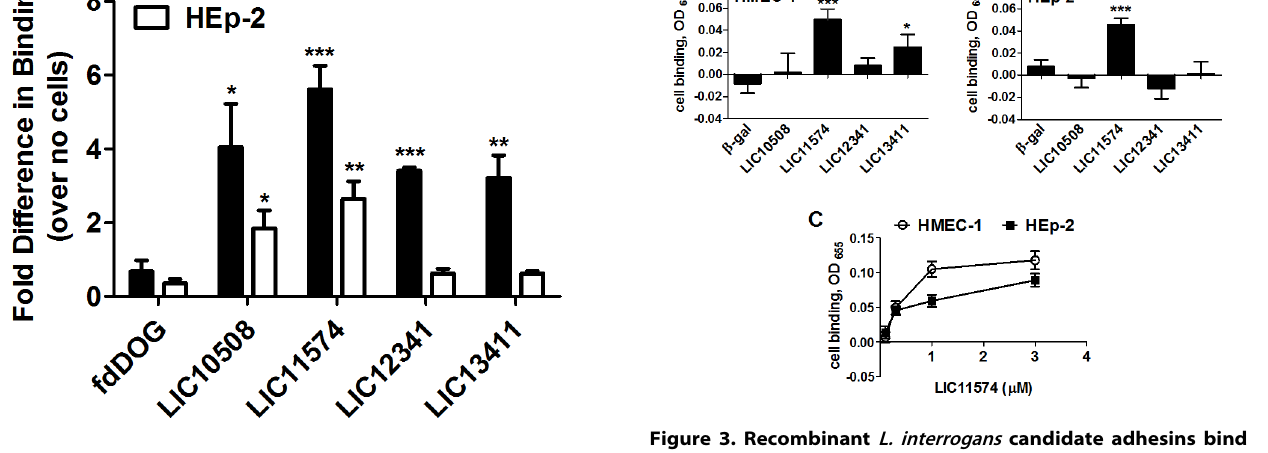
Figure 3. Recombinant L.interrogans candidate adhesins bind to cells. Recombinant forms of L. interrogans candidate adhesins expressed as fusions to MBP, along with b -galactosidase ( b -gal) were diluted to 0.3 m M and incubated with confluent monolayers of endothelial HMEC-1 (Panel A) or epithelial HEp-2 (Panel B) cells for 1 hr at 37 u C, 5% CO 2 . The unbound proteins were removed by washing and the bound adhesins were detected by ELISA using anti-MBP antibody. Results were expressed as the difference in the absorbance reading between wells with or without cells. The data shown are means 6 standard errors from 8 independent assays with n=8–28. Asterisks (*) indicate significant difference in binding when compared to the MBP fusion to b -gal, the negative control (two-tailed t- test, * P , 0.05, *** P , 0.001). Panel C shows concentration-dependent attachment of LIC11574 to endothelial and epithelial